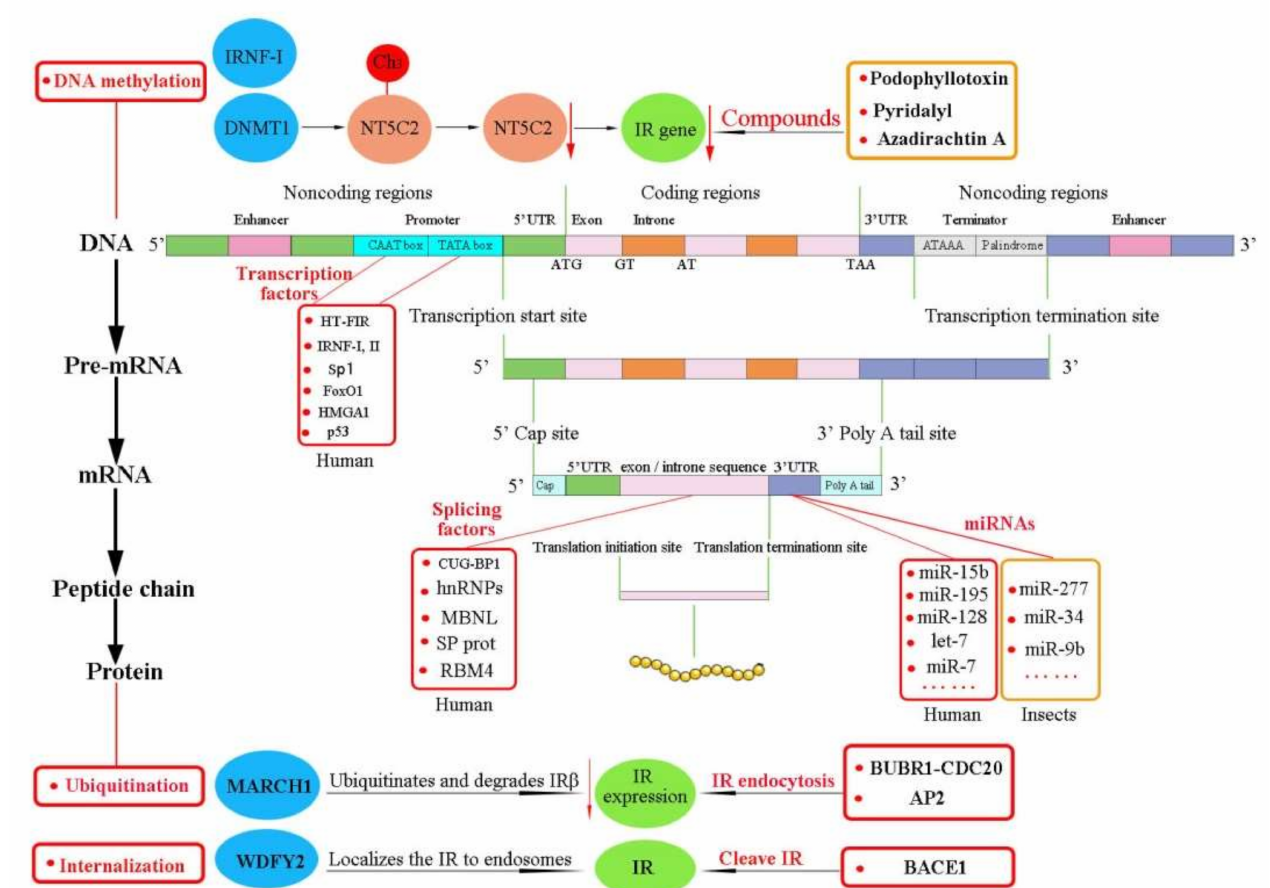
Figure 5. Summary of the principal IR regulators acting at the gene level (DNA methylation, xenobi- otic compounds, and transcription factors at promoter), mRNA level (miRNAs at 3 (cid:48) UTR), and protein level (ubiquitination, endocytosis, internalization, and cleavage). DNMT1, DNA methyltransferase